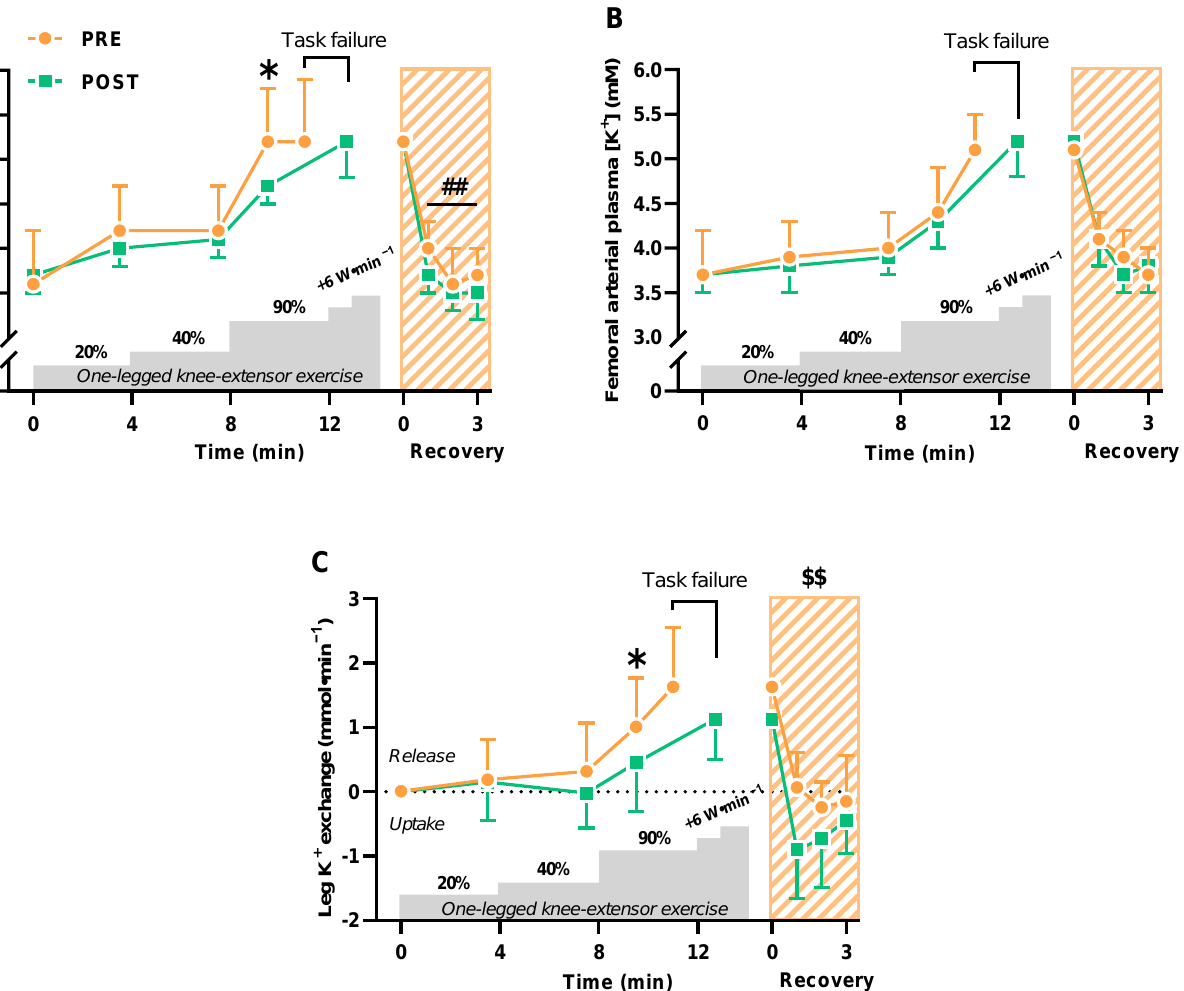
Figure 1. Exercise-related K + shifts during and 0–3 min into recovery from one-legged knee extensor exercise before (PRE) and after (POST) 6 weeks of high-intensity interval training (HIIT) 3 times weekly in young males (n = 9). ( A , B ) Femoral venous ( A ) and arterial ( B ) plasma K + concentrations. ( C ) Leg K + release and uptake. Data are presented as mean ± SD. * POST different from PRE ( p < 0.05). ## POST recovery values different from PRE ( p < 0.01). $$ Cumulated leg K + uptake after HIIT different from before ( p <